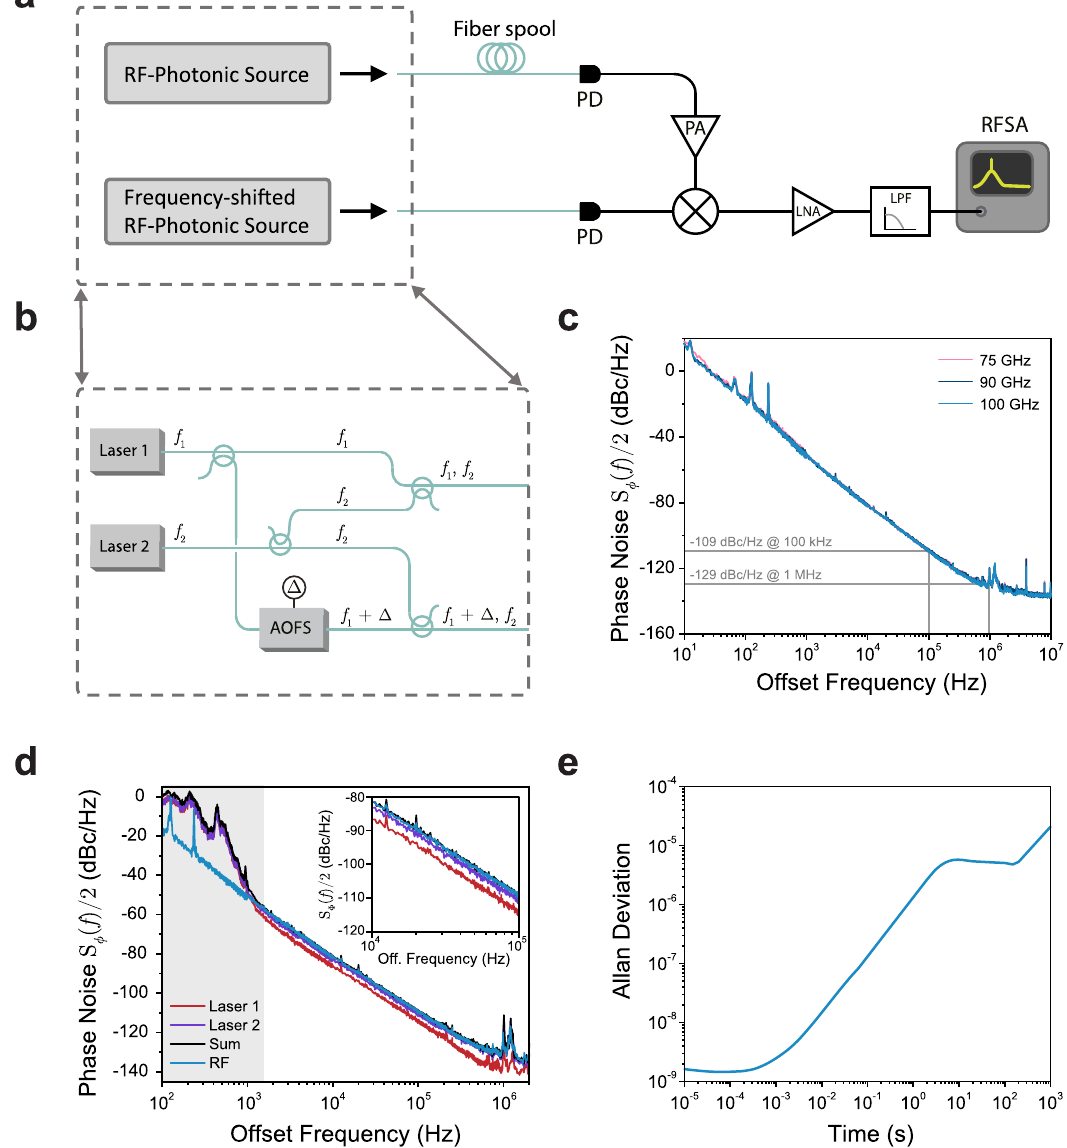
Fig. 2 Phase noise measurements of the heterodyne source. a diagrams the basic concept of the frequency discriminator experiment. Two copies of the millimeter-wave signal are synthesized by splitting the two lasers, but one is frequency-shifted by Δ = 100 MHz using an optical single-sideband modulator driven by an external low-noise microwave source. A long fi ber-optic delay line produces a time-delay τ between the two signals, partially de-correlating them. Each is then incident on a fast photodiode (PD). One signal is ampli fi ed to bias a W-band mixer, and the two signals are mixed down to Δ , before being passed through a low-noise ampli fi er (LNA) and low-pass fi lter. Phase (frequency) fl uctuations over the time delay τ are converted into a noise pedestal around Δ which re fl ects the phase noise content of the microwave source with a well-de fi ned transfer function. b shows how two pairs of frequency-detuned optical signals are synthesized from the same two lasers. One optical tone is shifted by + Δ using an acousto-optic frequency shifter (AOFS). c plots the measured single-sideband phase noise S ϕ ( f )/2 for output frequencies of 75, 90, and 100 GHz. Because the noise level of the source lasers does not change appreciably as they are tuned, the phase noise of the down-mixed microwave signal is constant with operating frequency. d compares the measured phase noise at 100 GHz with the measured phase noise of each laser. As expected, the phase noise of the microwave source matches the sum of the phase noise of the two lasers. At offset frequencies <1 kHz (shaded gray), additional fi ber-optic-induced noise from environmental vibrations prohibits accurate measurement of the laser phase noise. e plots the Allan deviation of the free-running source at a center frequency of 100 GHz. Below averaging times of 0.1 s, the Allan deviation is calculated from the phase noise distribution, while above 0.1 s it is calculated from frequency counter